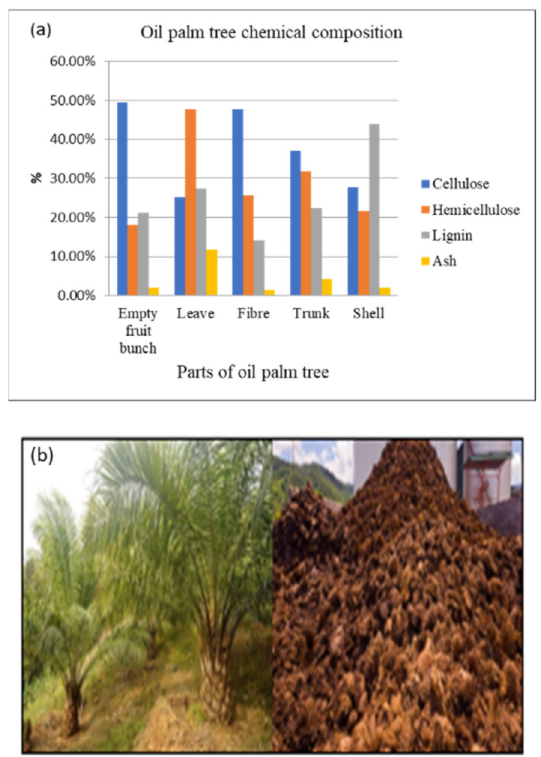
Figure 36. ( a ) Oil palm tree chemical composition and ( b ) oil palm tree and empty fruit bunches of oil palm dumped on